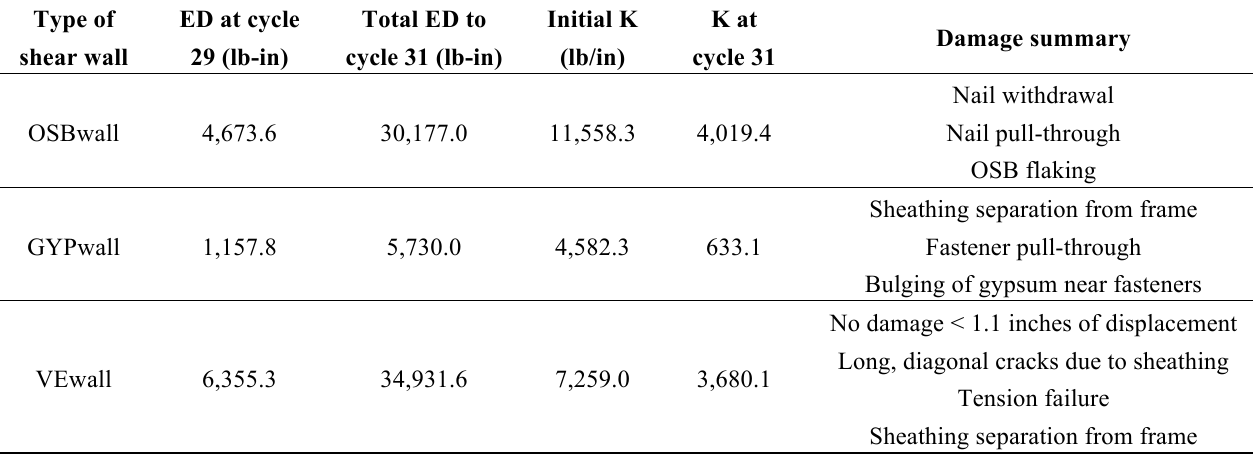
Table 7. Summary of wall